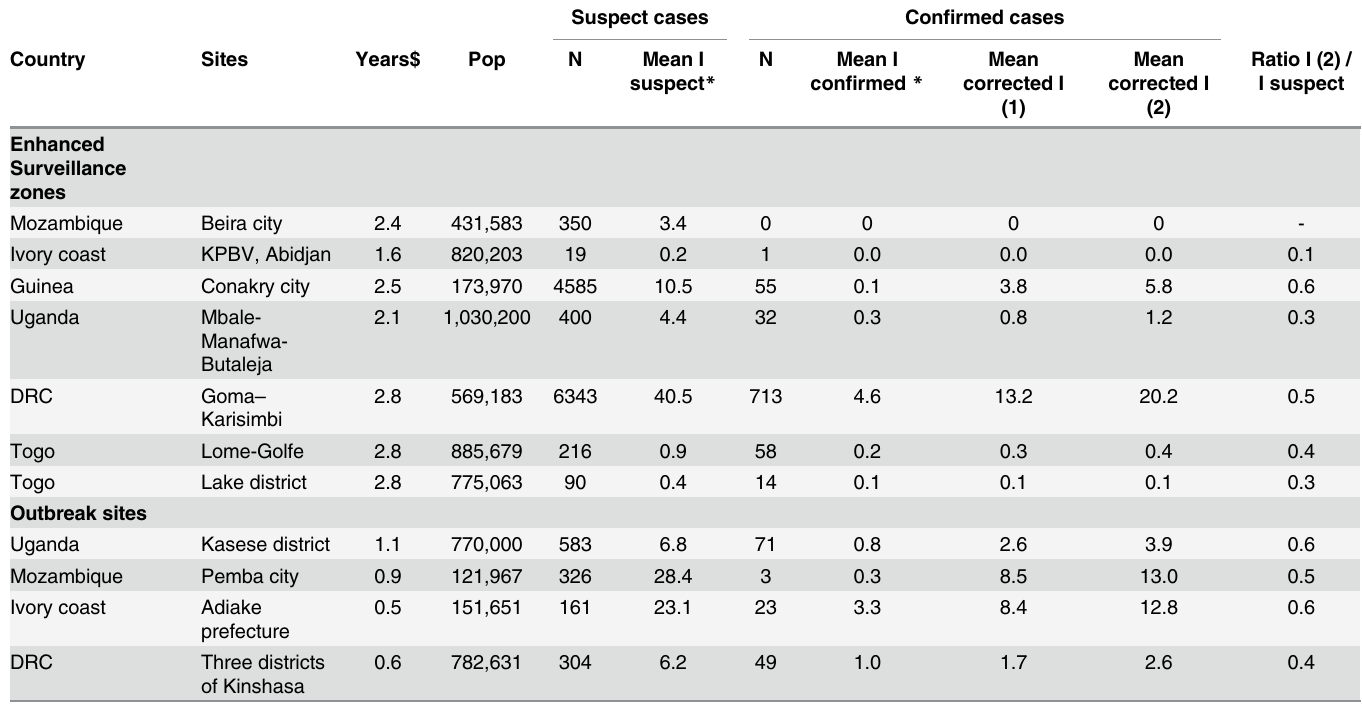
Table 5. Mean annual incidence rate of cholera suspect cases and culture confirmed cases (crude or corrected) in the Africhol sites. N =